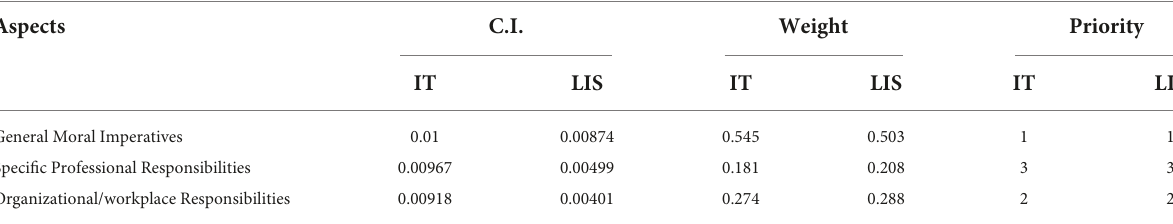
TABLE 12 Weights and ranking of three main criteria by information professionals in IT and LIS fields.